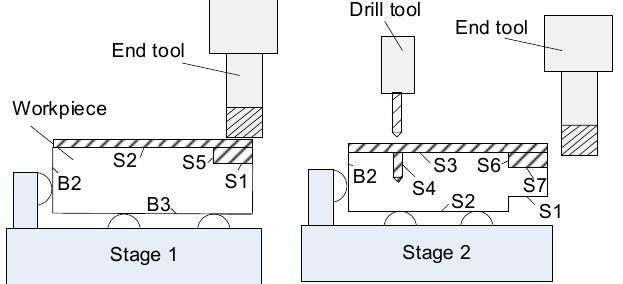
Figure 3. Example of an MMP to illustrate the qualitative model.